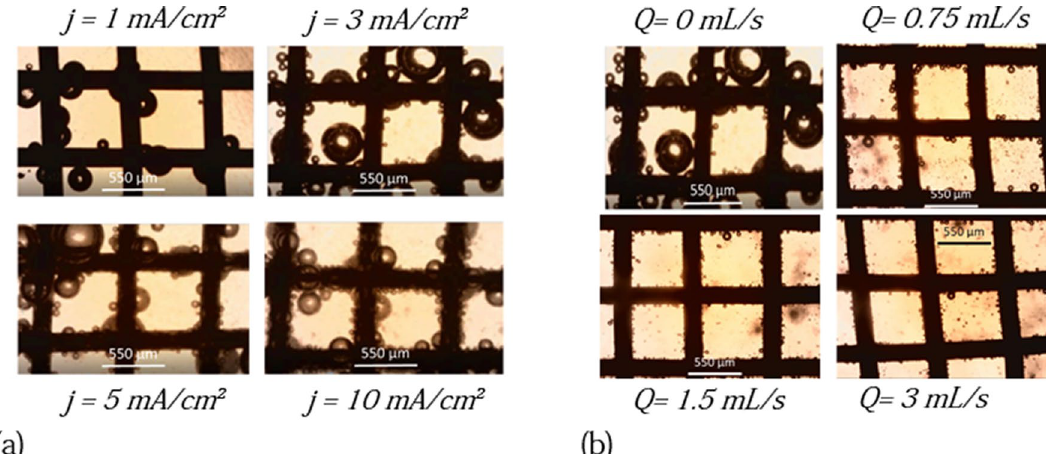
Figure 6. Picture of the bubbles on a grid of Nickel ( a ) as a function of the intensity current for Q = 0 mL s −1 . ( b ) As function of the flow rates for j = 3 mA cm −2